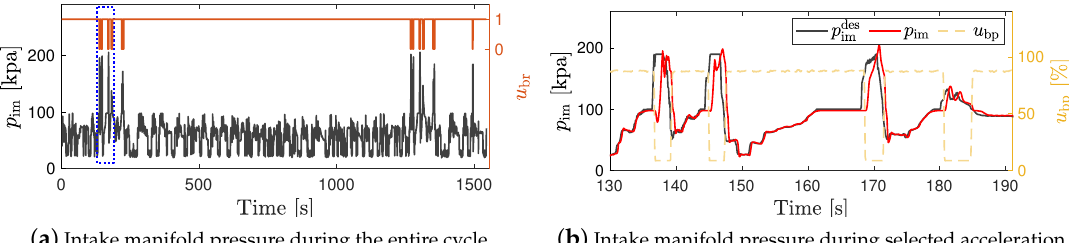
Figure 13. Intake manifold pressure during FTP75 cycle, ( a ) intake manifold pressure and PSS mode over the entire cycle, ( b ) intake manifold pressure, desired intake manifold pressure, and supercharger bypass during t = 130 s to t = 190 s.